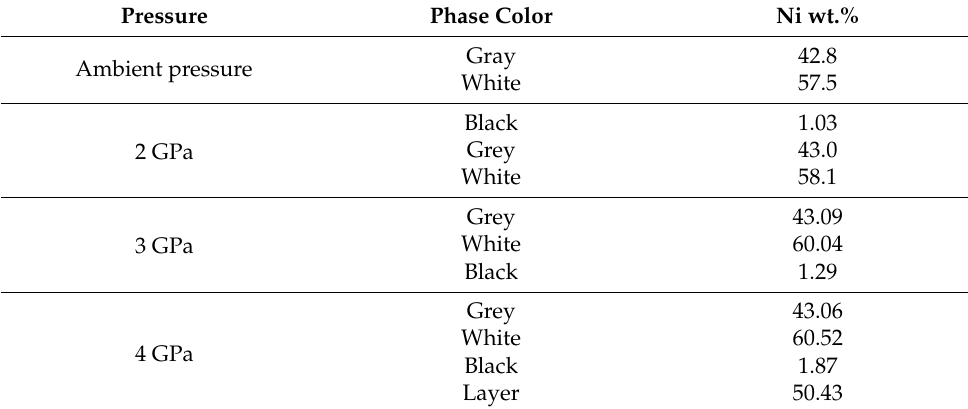
Table 1. The EDS results of Al-47wt.%Ni in Figure